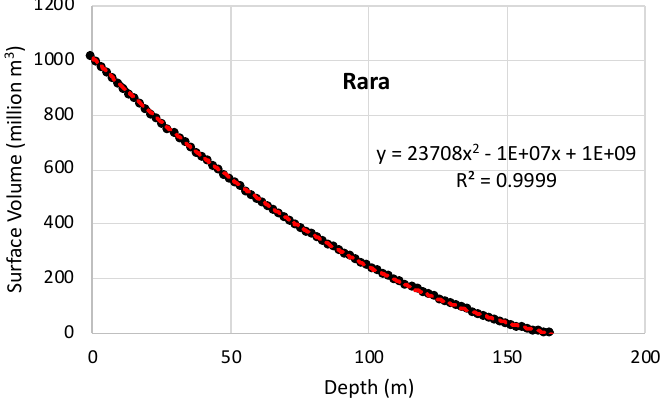
Figure 3. Relationship between water volume and depth of Rara Lake.